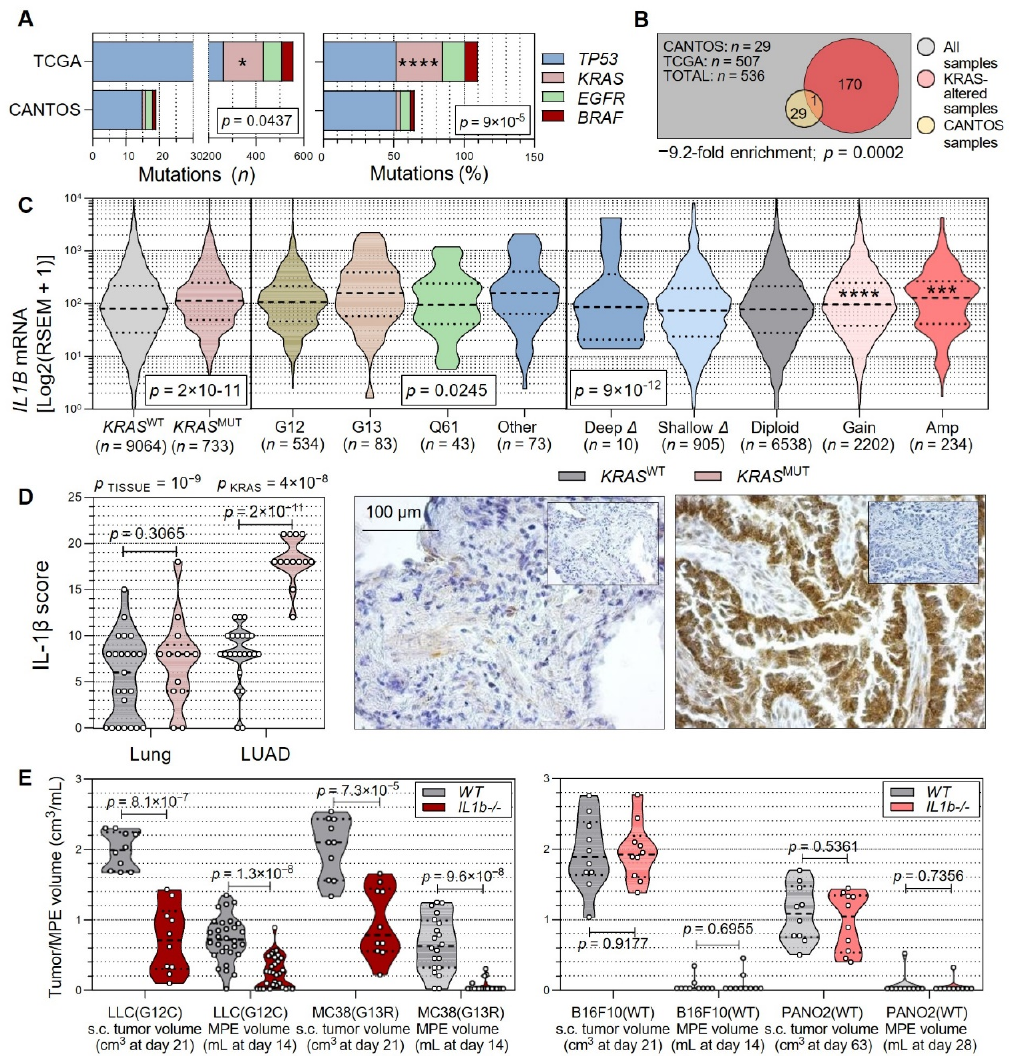
Figure 1. Non-oncogene addiction of KRAS -mutant cancers to interleukin (IL)-1 β . ( A , B ) TP53 , KRAS , EGFR , and BRAF mutation frequencies in the canakinumab anti-inflammatory thrombosis outcomes study (CANTOS) and the cancer genome atlas (TCGA) lung adenocarcinoma (LUAD) patients. Data from [2,50–52]. Shown are patient and mutation numbers ( n ) and percentages (%), as well as probabilities ( P ), χ 2 test ( A ) or hypergeometric test ( B ). ( C ) Data summary of KRAS alterations (G12, G13, Q61) versus IL1B mRNA expression in the cancer genome atlas (TCGA) pan-cancer dataset ( n = 10,967 samples from 10,953 patients with 31 different cancers) from the US. Data from [51,52]. RSEM, RNA-Seq by Expectation-Maximization. Note the elevated IL1B mRNA expression of KRAS -altered cancers. ( D ) Data summary (left) and representative images (right; inlays: isotype controls) of KRAS alterations versus IL-1 β protein expression in lung adenocarcinoma (LUAD) and adjacent lung tissue from n = 36 resected patients from Munich, Germany. Note the elevated IL-1 β protein expression of KRAS -altered LUAD. ( E ) Data summary of subcutaneous (s.c.) tumor and malignant pleural effusion (MPE) volume of C57BL/6 mice competent ( WT ) or diploinsufficient ( Il1b-/- ) in Il1b alleles at the indicated time-points after s.c. or intrapleural injection of 5 or 2 × 10 5 tumor cells, respectively, with (left; n from left to right = 10, 10, 30, 30, 10, 10, 20, and 20) or without (right; n = 10/group) Kras mutations. Note the requirement of Kras -altered tumors for host IL-1 β . Shown are raw data (circles), rotated kernel density distributions (violins), medians (dashed lines), quartiles (dotted lines), and p , probabilities, Kolmogorov–Smirnov or Kruskal–Wallis test ( A ), two-way ANOVA ( B , above graph) and Bonferroni post-tests ( B , in graph), or unpaired t -tests ( C ). *, *** and ****: p < 0.05, p < 0.001 and p < 0.0001, respectively, compared with diploid patients, Dunn’s post-tests.